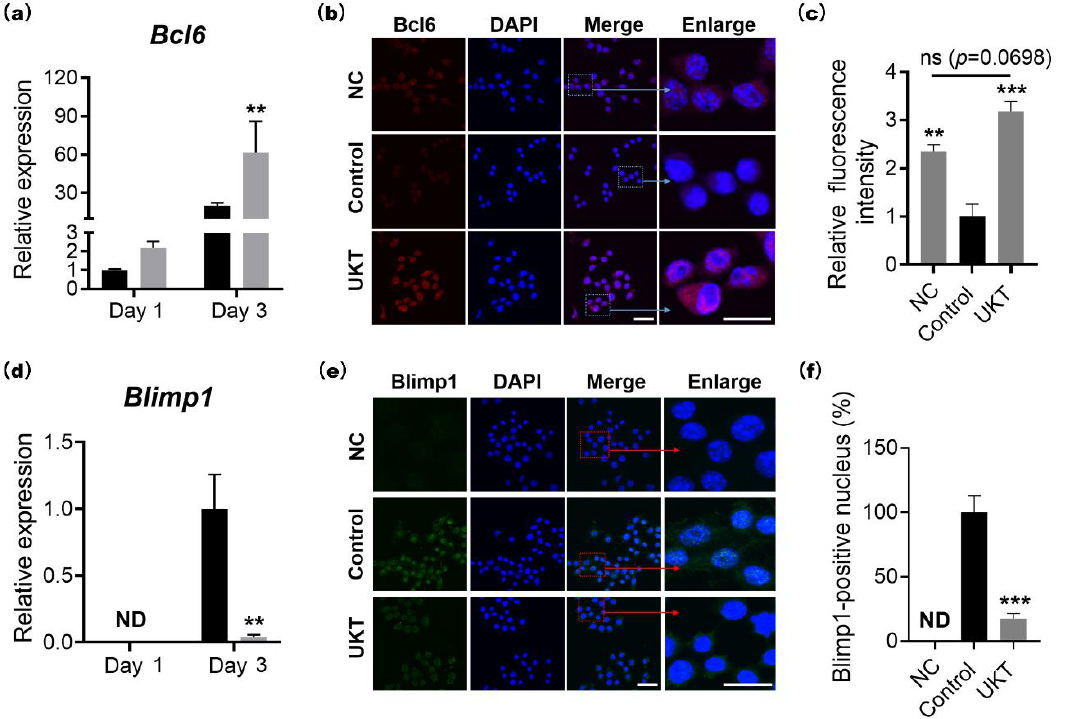
Figure 3. Unkeito (UKT) suppresses nuclear factor of activated T cells 1 (NFATc1) through the Blimp1 – Bcl6 axis by increasing Bcl6 expression. ( a ) mRNA expression level of Bcl6 normalized to that of Gapdh ; ( b ) abundance of Bcl6 72 h after RANKL stimulation in the presence or absence of UKT ( n = 3; scale bar = 10 µm, 2 µm); ( c ) relative fluorescence intensity of Bcl6; ( d ) mRNA expression level of Blimp1 normalized to that of Gapdh ; ( e ) protein level of Blimp1 72 h after RANKL stimulation in the presence or absence of UKT ( n = 3; scale bar = 10 µm, 2 µm); ( f ) intra-nuclear level of Blimp1 . Error bars represent ± standard error of the mean. ** p < 0.01, *** p < 0.005, versus control groups on the same day. Black box: control; gray box: UKT; NC: negative control; ND: not detected.